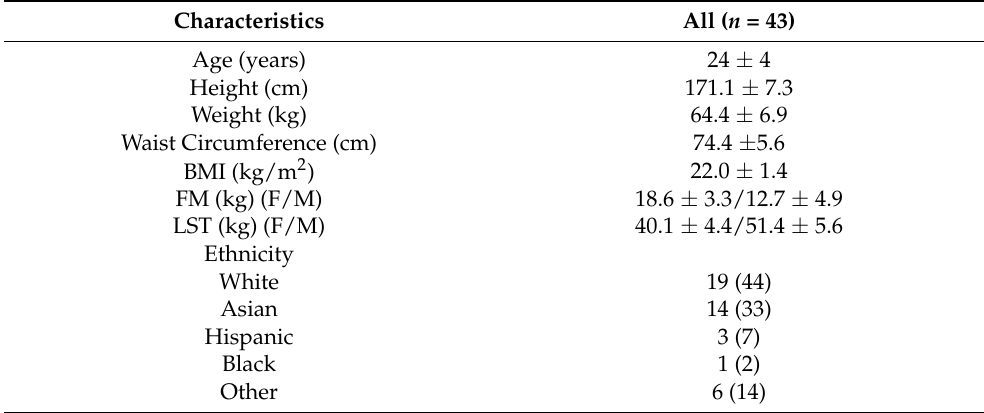
Table 2. Baseline characteristics of participants.